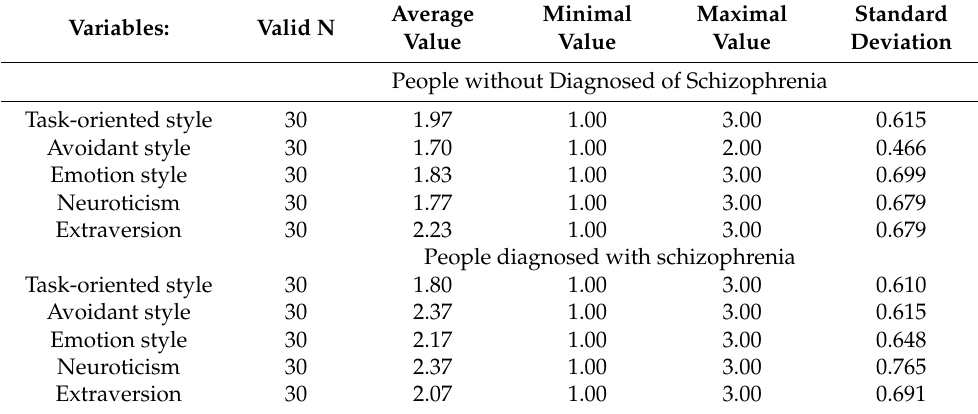
Table 2. Descriptive statistics of variables: style of coping with stress and selected dimensions of personality (average values, min and max values, standard